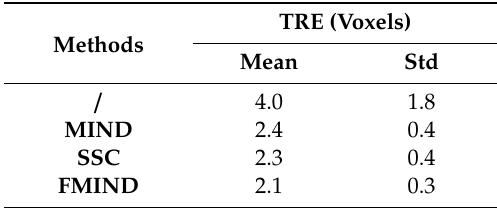
Table 7. The TRE for the MIND, self-similarity context (SSC), and FMIND methods operating on the real T1-PD image